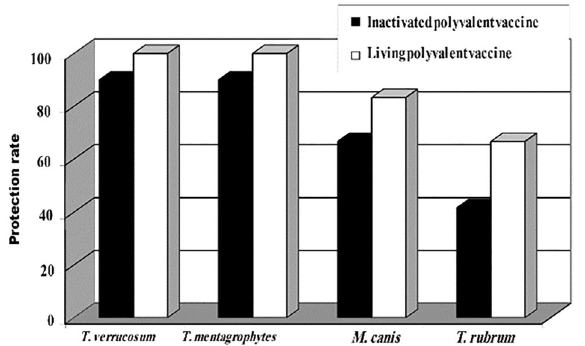
Figure 1. Protective efficacy of the inactivated and the living non-adjuvanted polyvalent dermatophyte vaccines against challenge with virulent dermatophyte